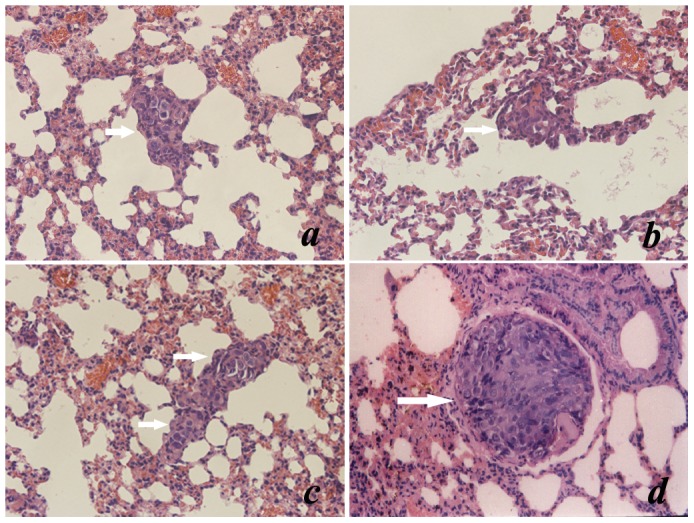
Representative images of pulmonary metastatic foci.Shortly after mice were sacrificed, lungs were entirely resected and were fixed in formalin, histological slices were manufactured. (a) and (b) are the representative H&E staining images of pulmonary metastatic foci of LDA group and HDA group, respectively (200×); (c) and (d) are the images of control group, illustrating representative pulmonary metastatic colonizations and intravascular tumor embolus, respectively (200×).